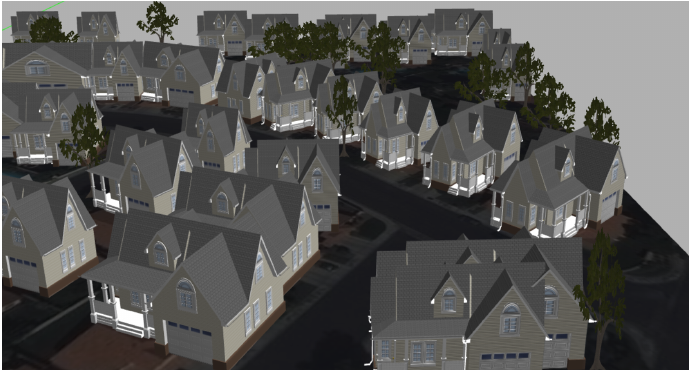
Figure 5. Gazebo image of simulation with rotated houses. Notice houses bordering roads face towards them for a more realistic